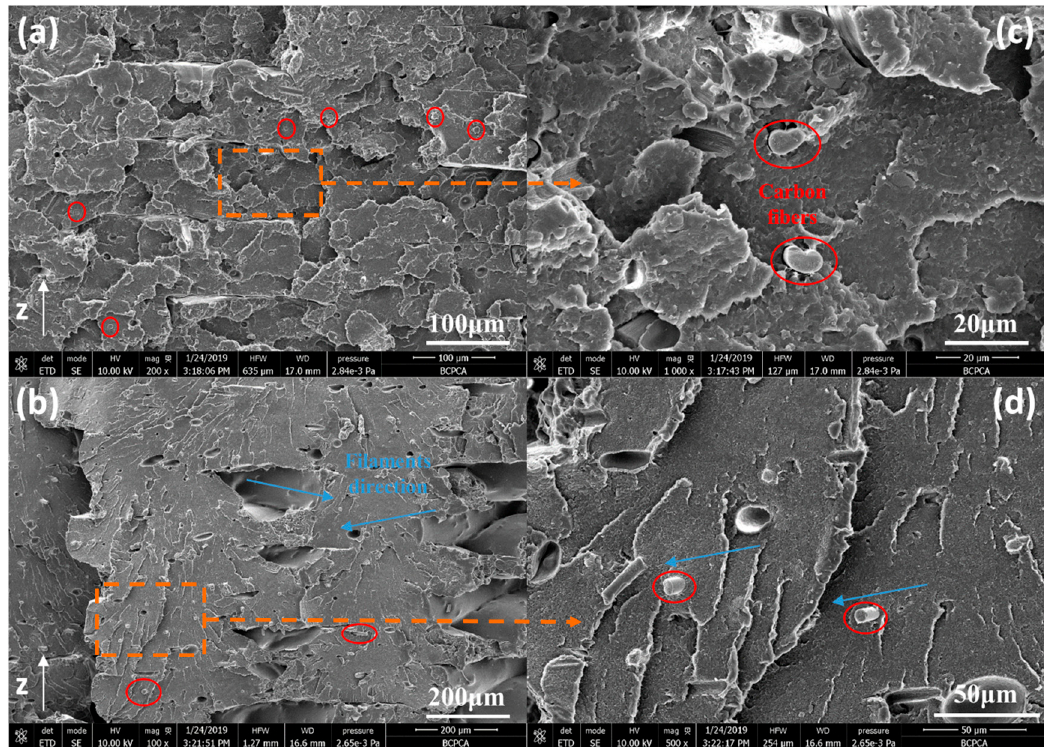
Figure 3. SEM of brittle flexural fractured cross-section of printed CF / PEEK parts. ( a ) The shell of printed CF / PEEK parts. ( b ) The core of printed CF / PEEK parts. ( c ), ( d ) The enlarged figures of ( a ), ( b ), respectively (red circles and blue arrows mean carbon fibers and direction of printing filaments, respectively).